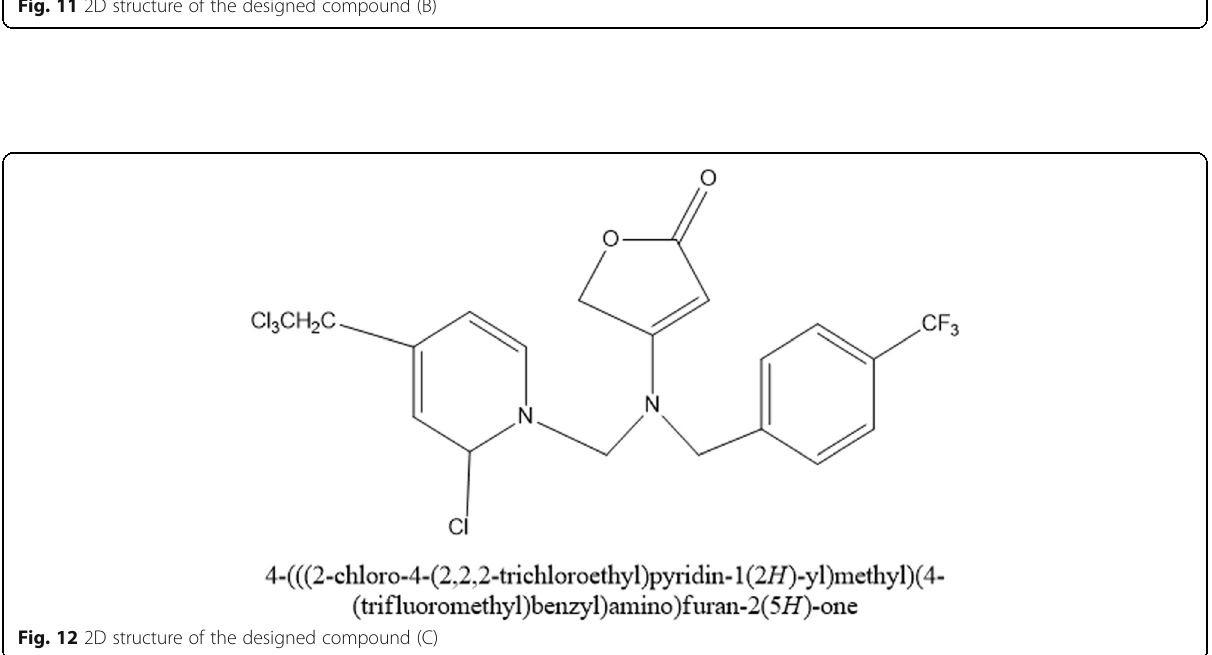
Fig. 12 2D structure of the designed compound